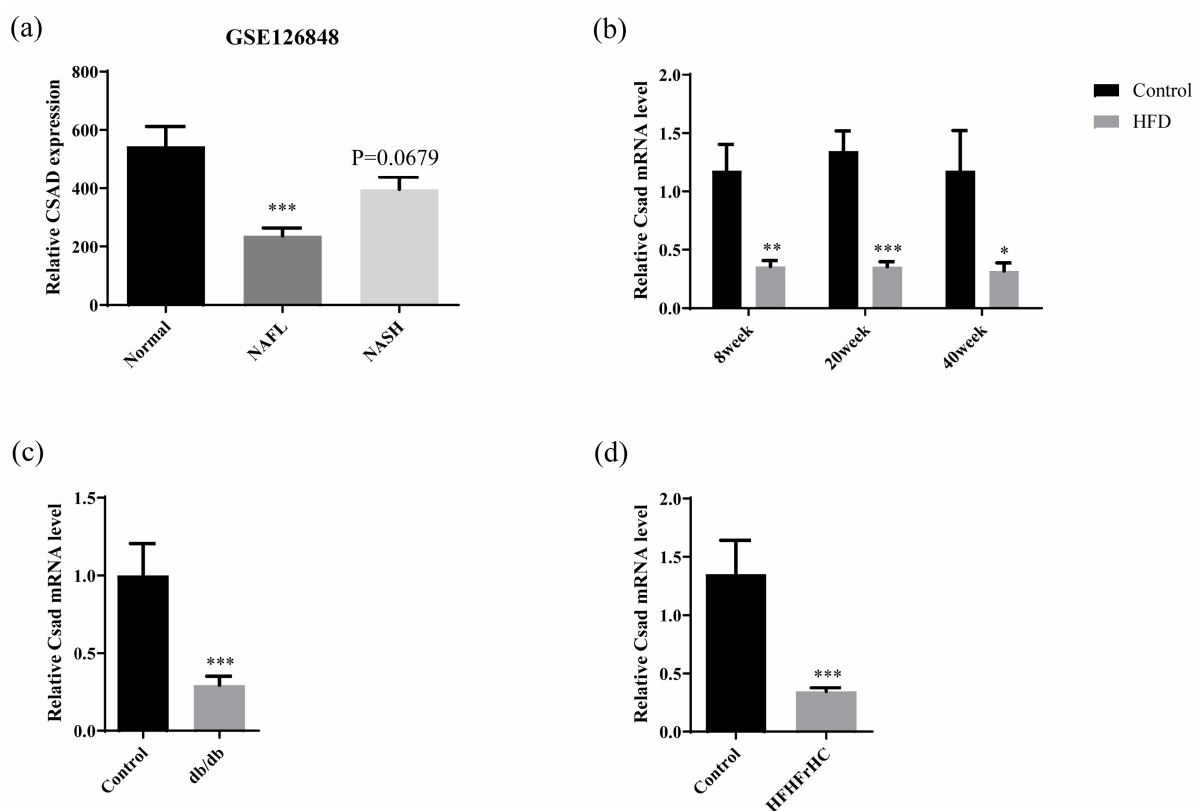
Figure 1. CSAD was reduced when compared with healthy controls in several NAFLD models. ( a ) The level of hepatic CSAD mRNA in the clinical database (GEO126846); n = 14 in the normal group, n = 15 in the NAFLD group, and n = 16 in the NASH group. *** p < 0.001 vs. normal group. ( b ) The levels of Csad mRNA in the livers of HFD mice and control mice; n = 4–6 in each group. The mice were fed with a high-fat diet (HFD group) or normal diet (control group) for 8, 20, and 40 weeks respectively. Then, the level of Csad mRNA in the liver was detected by RT-qPCR; * p < 0.05, ** p < 0.01, *** p < 0.001 vs. the control group. ( c ) The levels of Csad mRNA in the livers of db / db mice and WT mice; n=5 in each group. The db / db mice and WT littermates were fed a normal diet for 20 weeks. Then, the level of CSAD mRNA in the liver was detected by RT-qPCR; *** p < 0.001 vs. the control group. ( d ) The levels of Csad mRNA in the livers of HFHFrHC mice and control mice; n = 3–10 in each group. The mice were fed a high-fat, high-fructose, and high-cholesterol diet (HFHFrHC group) or a normal diet (control group) for 20 weeks. Then, the level of Csad mRNA in the liver was detected by RT-qPCR. *** p < 0.001 vs. control